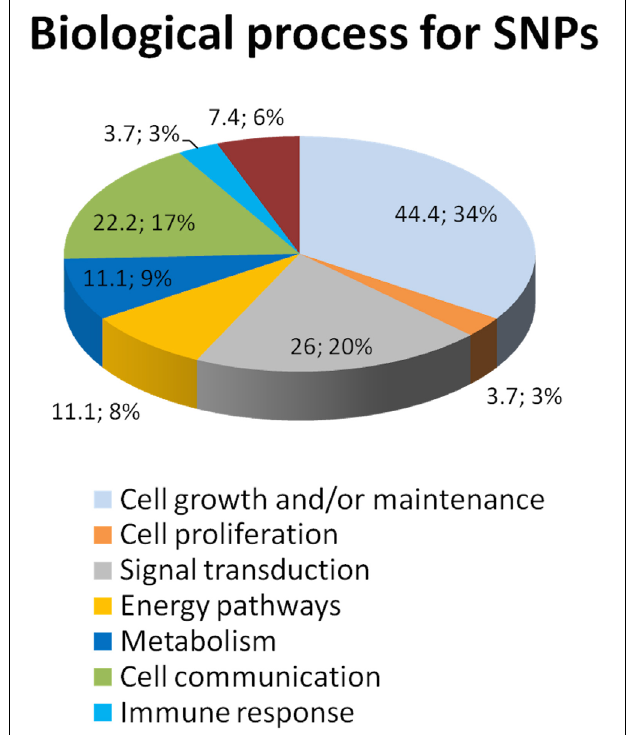
FIGURE 2 | Ontology group analysis revealed that SNPs resulting from DAPC analysis belong to several biological processes. We utilized the Sub-Network Enrichment Analysis (SNEA) to determine the possible pathways that are responsible for the CS response. SNEA is based on the Gene Set Enrichment Analysis algorithm. Sub-Networks of the potential pathways that regulate CS response are calculated de novo from the information in the data-sets and consist of a seed/regulator and their neighbors (targets) in the database. The seeds of the sub-network whose targets are statistically enriched are implicated as important regulators (cell processes) by the experimental data. The data shows that these 43 prioritized SNPs are involved in the pathways regulate cytokines, GR signaling, the TNF-induced cytotoxicity, and many